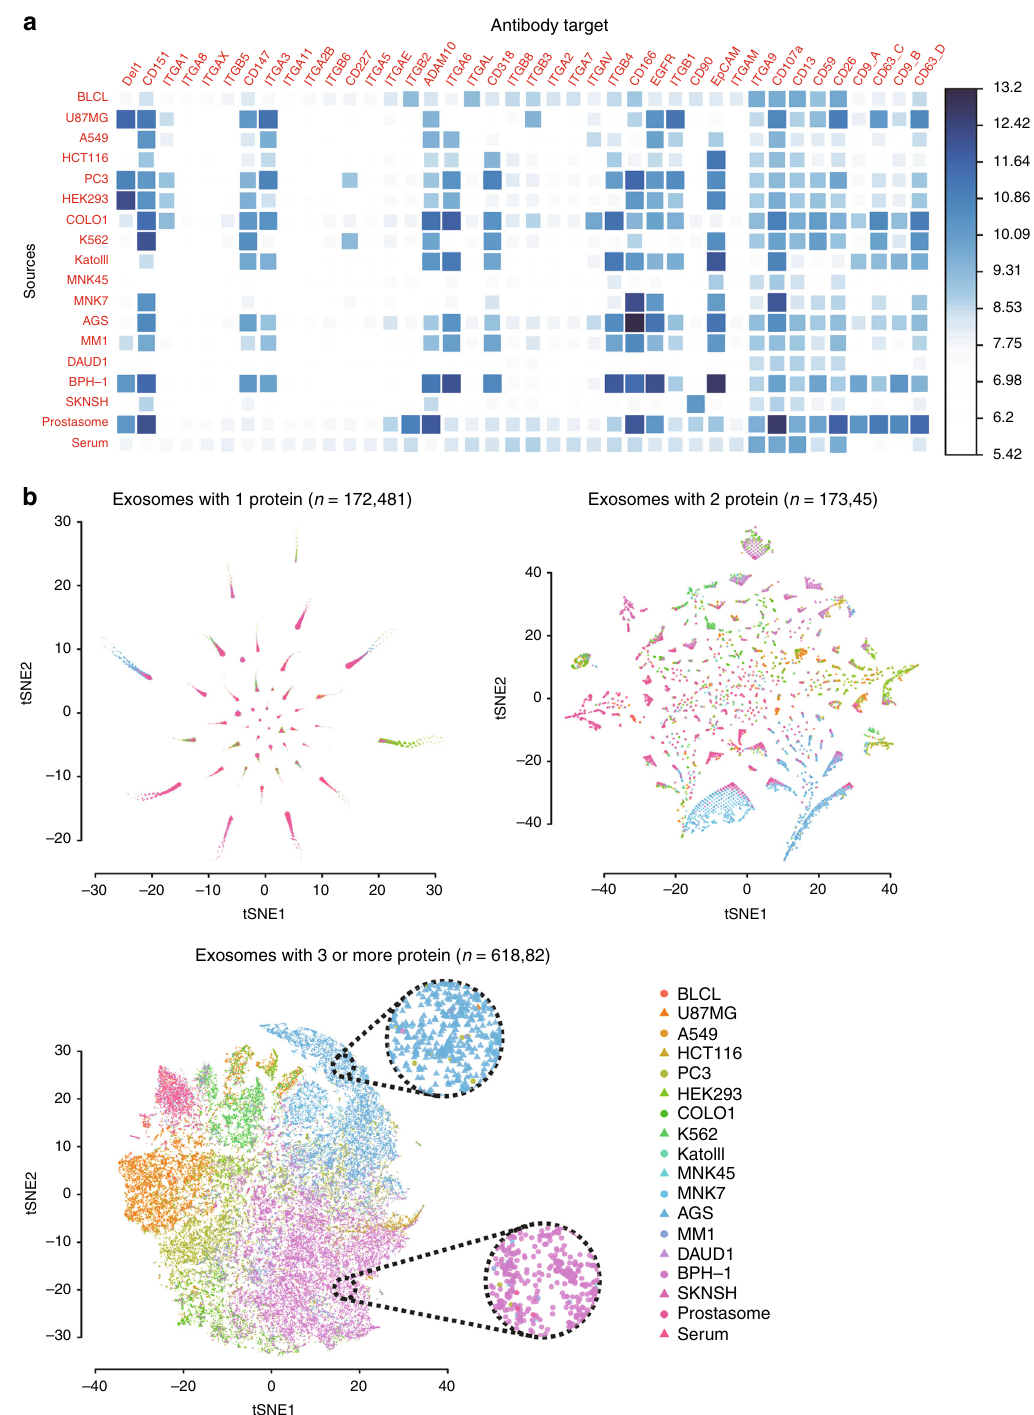
Fig. 4 Bulk protein counts and visualization of individual exosomes. a , b Exosomes from 18 different samples were analyzed for the presence of 38 proteins (40 proteinTags) by PBA. a Heatmaps representing the total amounts of the proteins by log(moleculeTag + 1) found on exosomes from different sources. b Individual exosomes with one identi fi ed protein type, two protein types, and three or more protein types were visualized by t-SNE according to their protein compositions, with color and shape of the symbols representing the source of each exosome. Cells from two regions dominated by exosomes from the cell lines AGS and BPH-1 are highlighted in circles with dotted